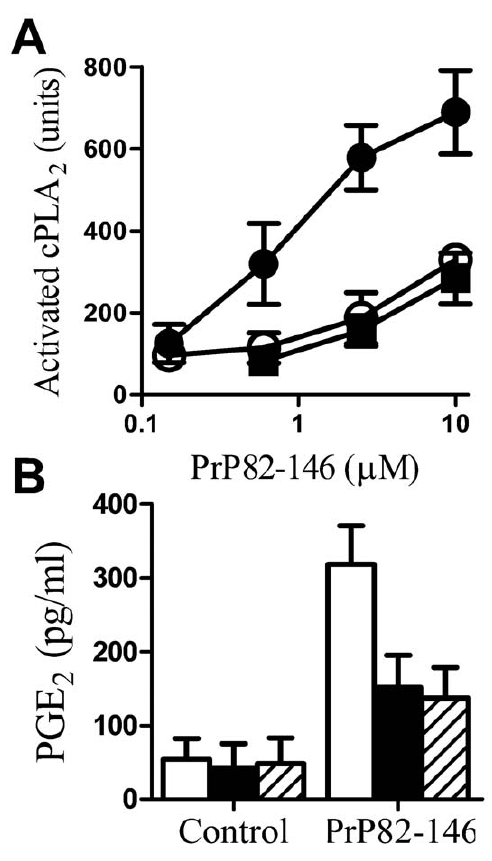
Figure 11. Glimepiride reduced the activation of cPLA 2 by PrP82–146. The amount of activated cPLA 2 in cell extracts from cortical neurones pre-treated for 1 hour with a vehicle control ( glimepiride ( # ) or PI-PLC ( & ) and incubated with varying concentra- tions of PrP82–146 for 24 hours. Values shown are the mean average amount of activated cPLA 2 (units) 6 SD, n=12. (B) The amount of PGE 2 in cell extracts from cortical neurones pre-treated for 1 hour with control medium ( % ), 5 m M glimepiride ( & ) or PI-PLC (striped bars) and incubated with control medium or 10 m M PrP82–146. Values shown are the mean average amount of PGE 2 (pg/ml) 6 SD, n=9.